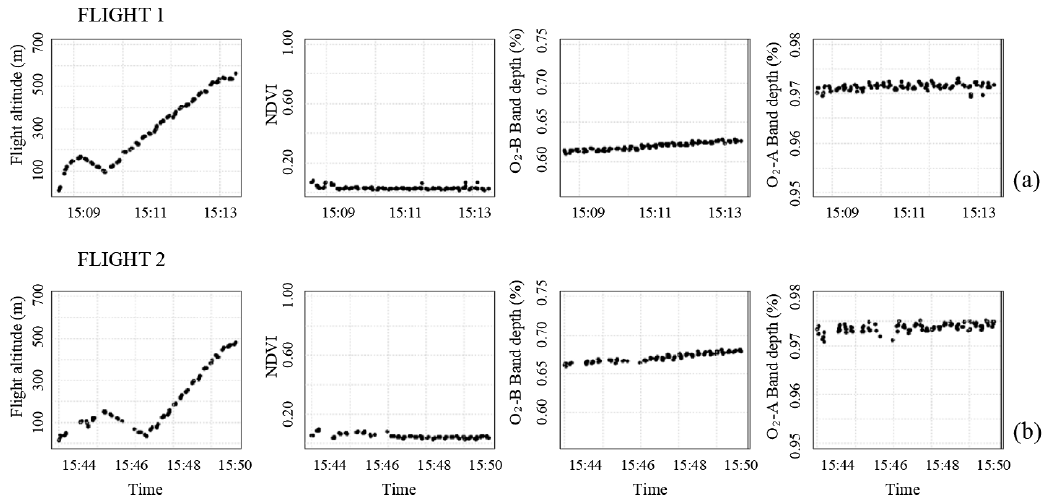
Figure 8. Flight altitude, pseudo-NDVI, and O 2 -A and O 2 -B relative bands depth for the ( a ) first and ( b ) second preliminary flights up to 600 m AGL. The first plots on each panel show the relation between the time and the flight altitude.